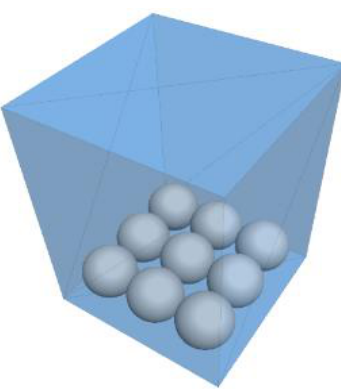
Figure 5. Calculation of porosity of mixture.